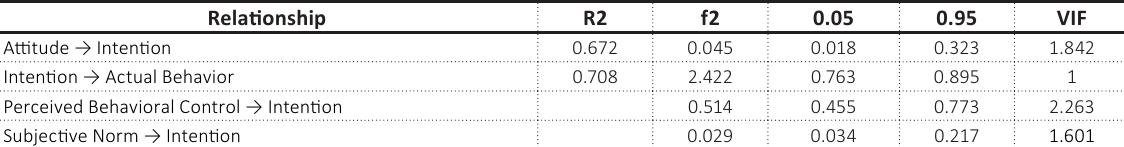
Table 5. Coefficient of determination